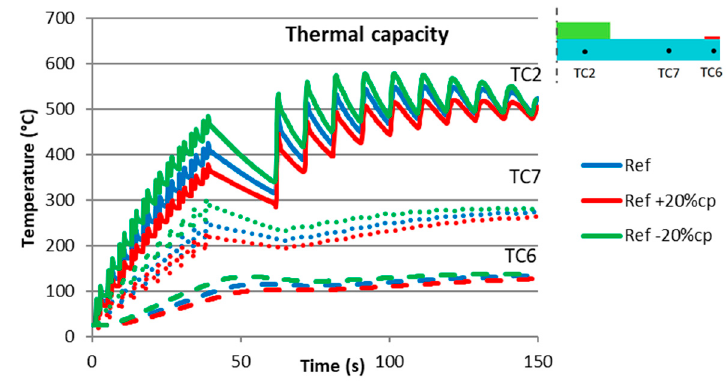
Figure 15. Sensitivity of thermal capacity variation of both clad and substrate on the thermal history.